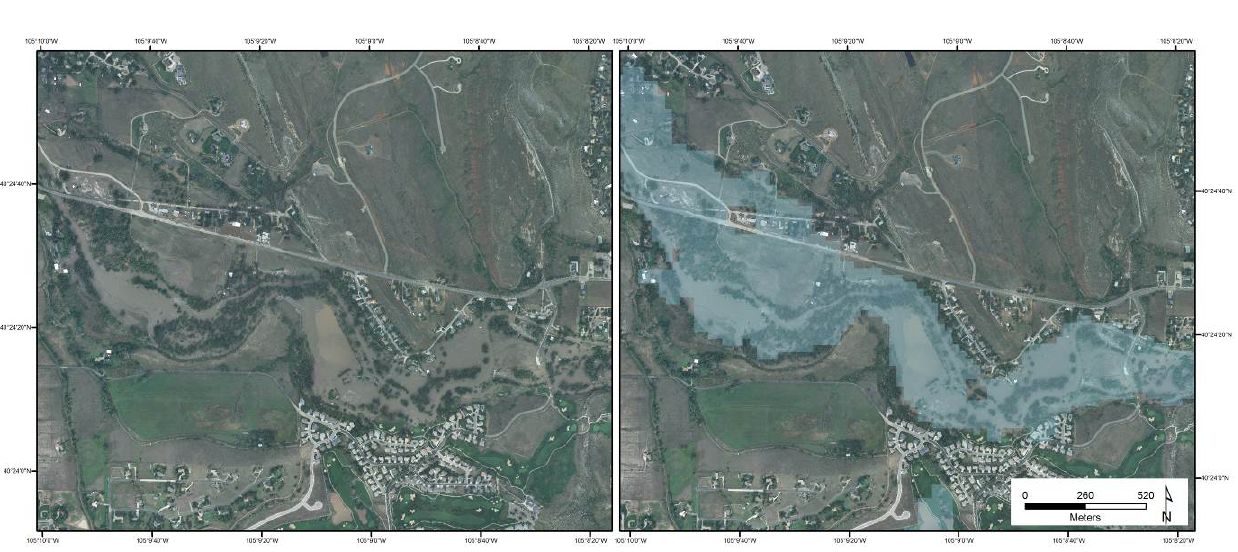
Figure 5. Orthophotograph of a reach of the Cache la Poudre River in Fort Collins, Colorado. The left image shows the flooding as of 14 September 2013, and the right shows the same image overlaid with the ICA modeled flood (semi-transparent blue). The flood layer closely agrees with turbid, inundated areas as well as adjacent banks scoured during the peak of the flooding.